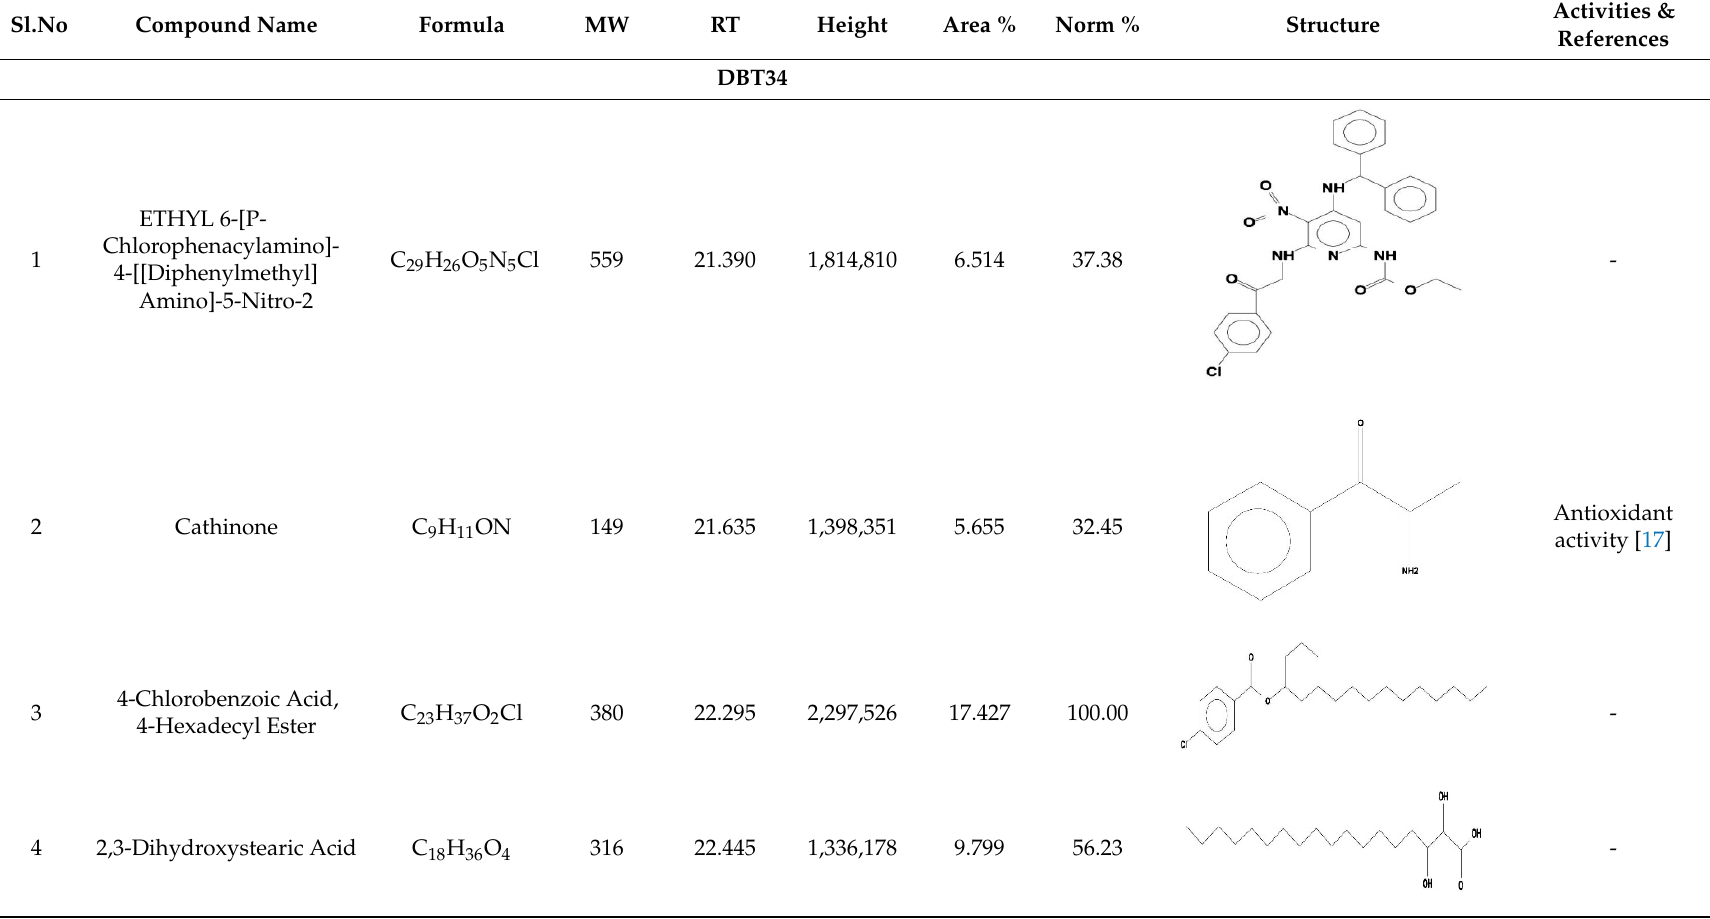
Table 2. Identification ofvolatile compounds (VOCs) in a methanolic extract of Streptomyce s sp. strain DBT34.